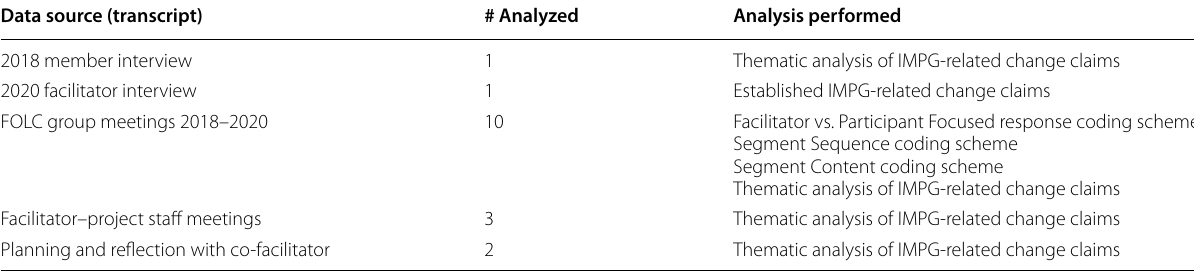
Table 2 Data sources and analyses applied during the study Data source (transcript)